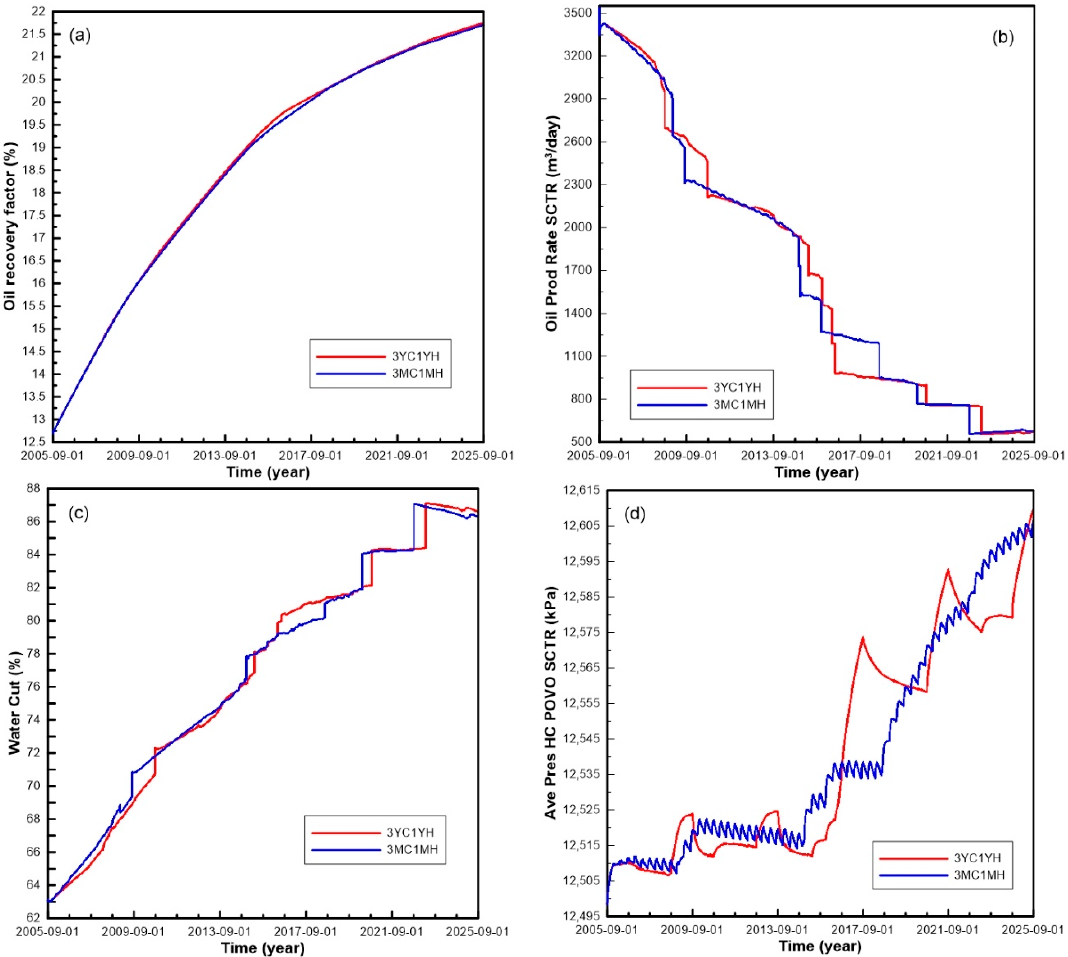
Figure 11. Simulated result curves of oil recovery factor ( a ), oil production rate ( b ), water cut ( c ) and average reservoir pressure ( d ) of during the CO 2 flooding with a WAG ratio of 3:1.